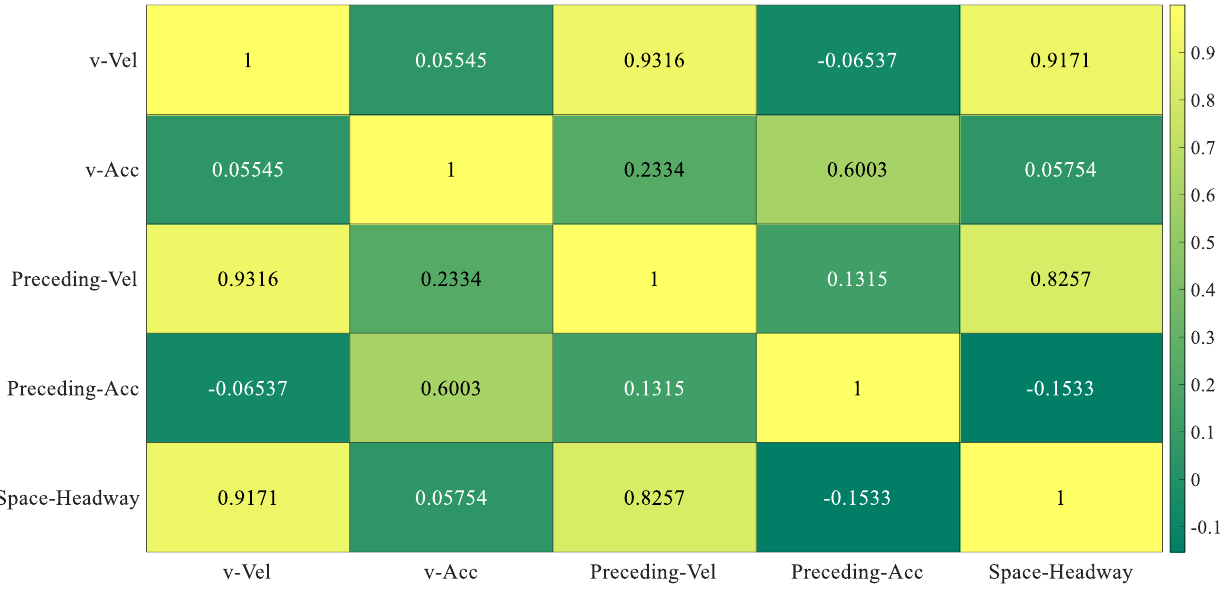
Figure 5. Spearman coefficient analysis results.